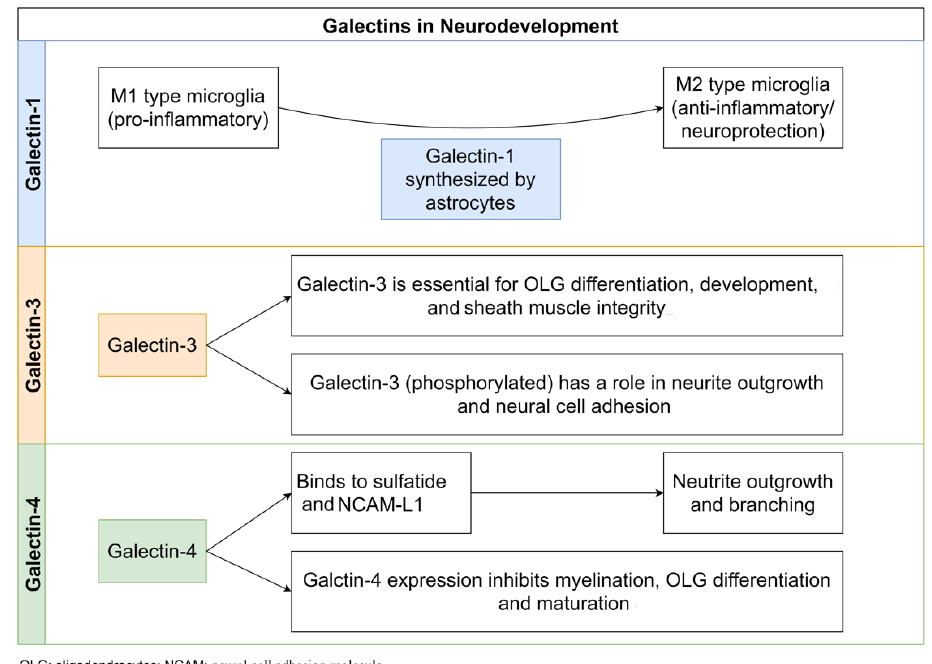
Figure 3. Role of Gals in